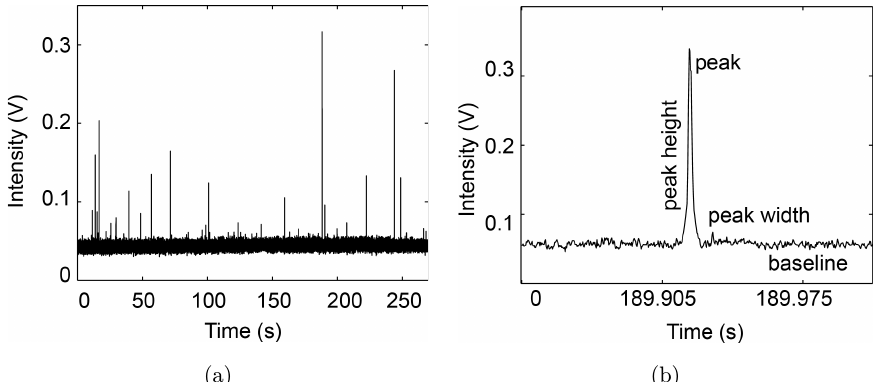
Fig. 1. Graphic signals of IVFC. (a) A representative IVFC signal. (b) The representative °uorescence signal pro¯le of a cell.